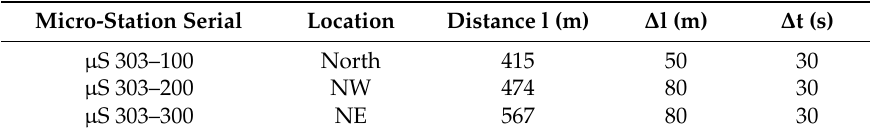
Table A6. Uncertainties in smoke travel time and distance.